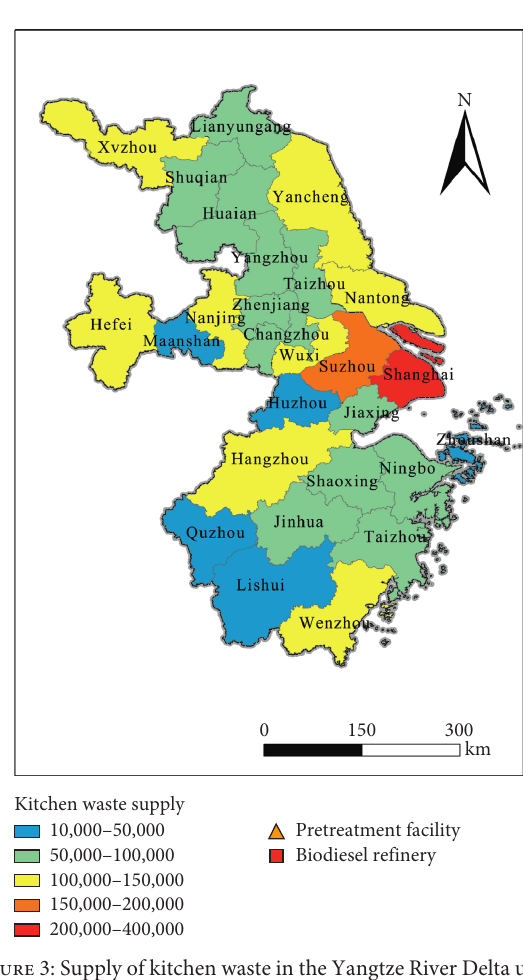
Figure 3: Supply of kitchen waste in the Yangtze River Delta under standard